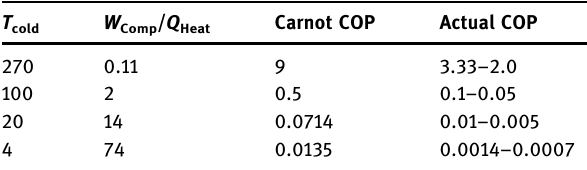
Table 1: Carnot and actual COP values obtained in refrigeration T